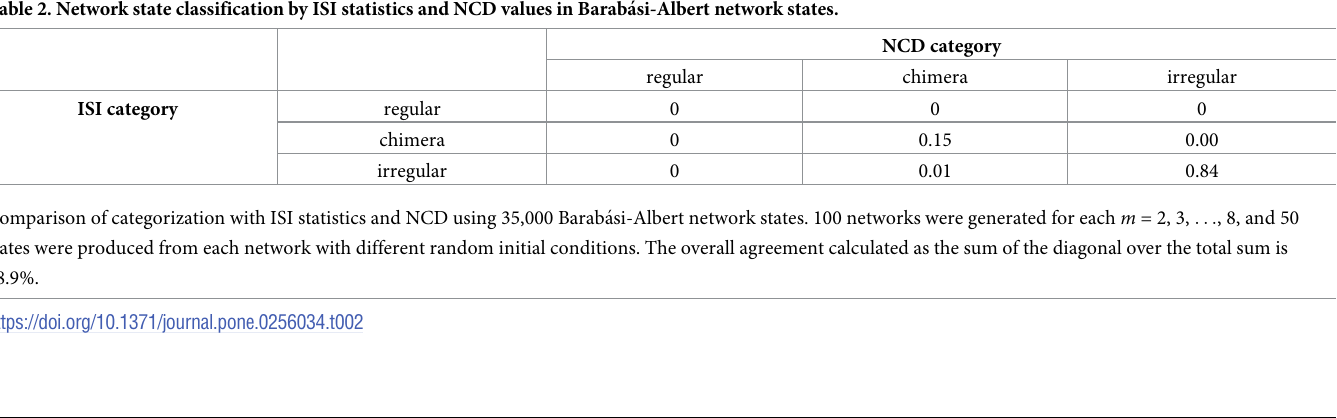
Table 2. Network state classification by ISI statistics and NCD values in Baraba´si-Albert network states.